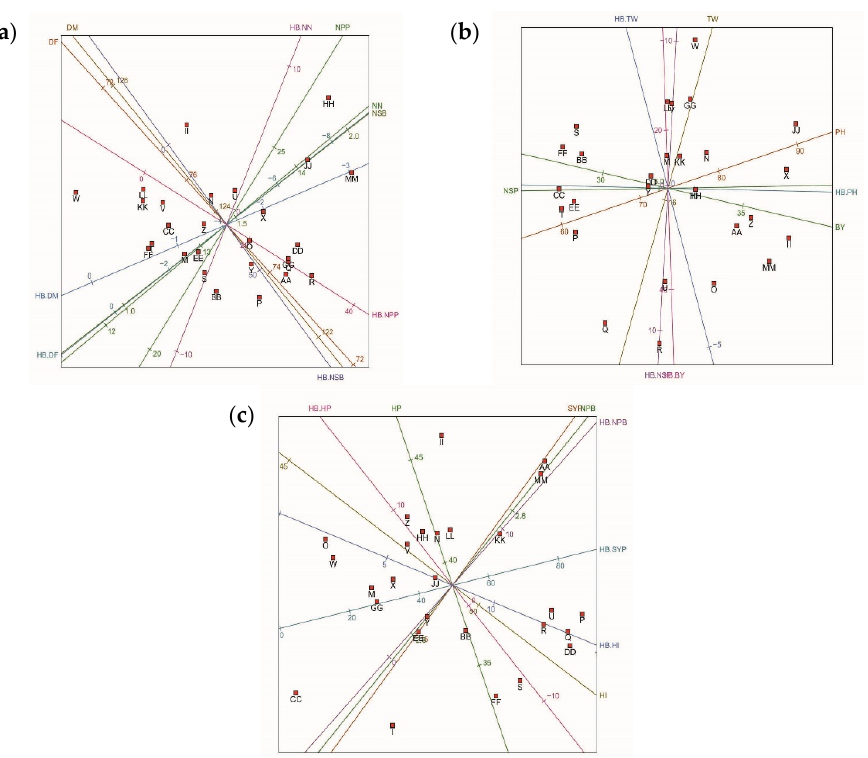
Figure 3. Principal component analysis (PCA) biplot diagrams for heterosis and mean values for crosses are shown in separate diagrams ( a – c ).